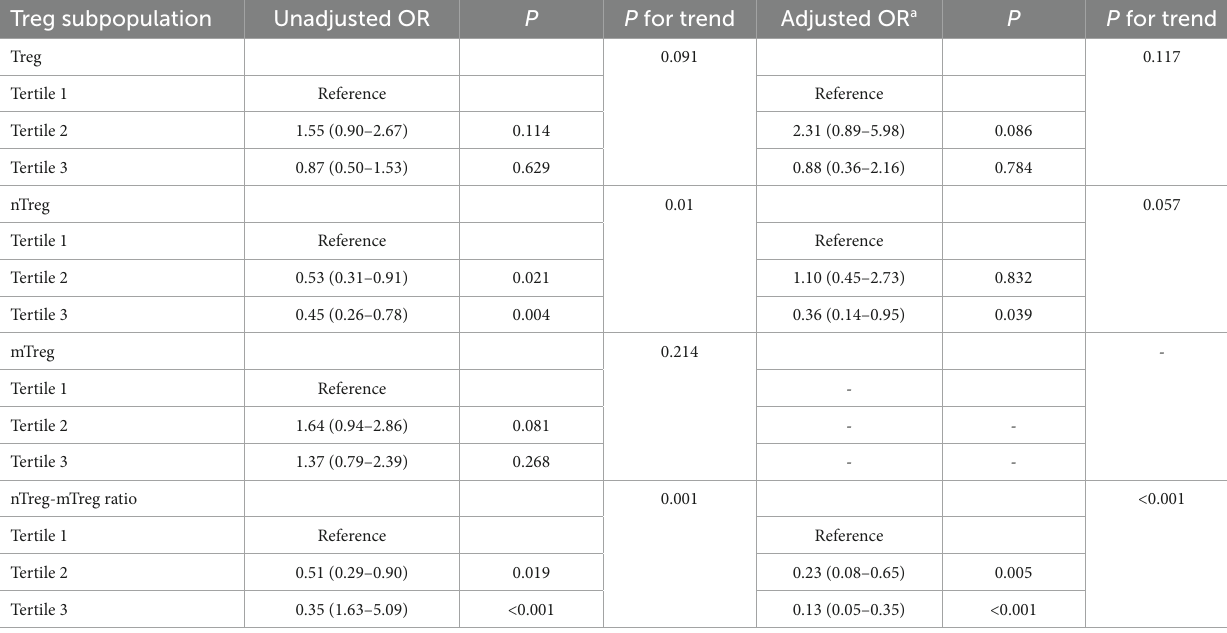
TABLE 3 Univariate and multivariate logistic regression analyzes depicting the associations of admission Treg subpopulation with 90 day unfavorable outcome. Treg subpopulation